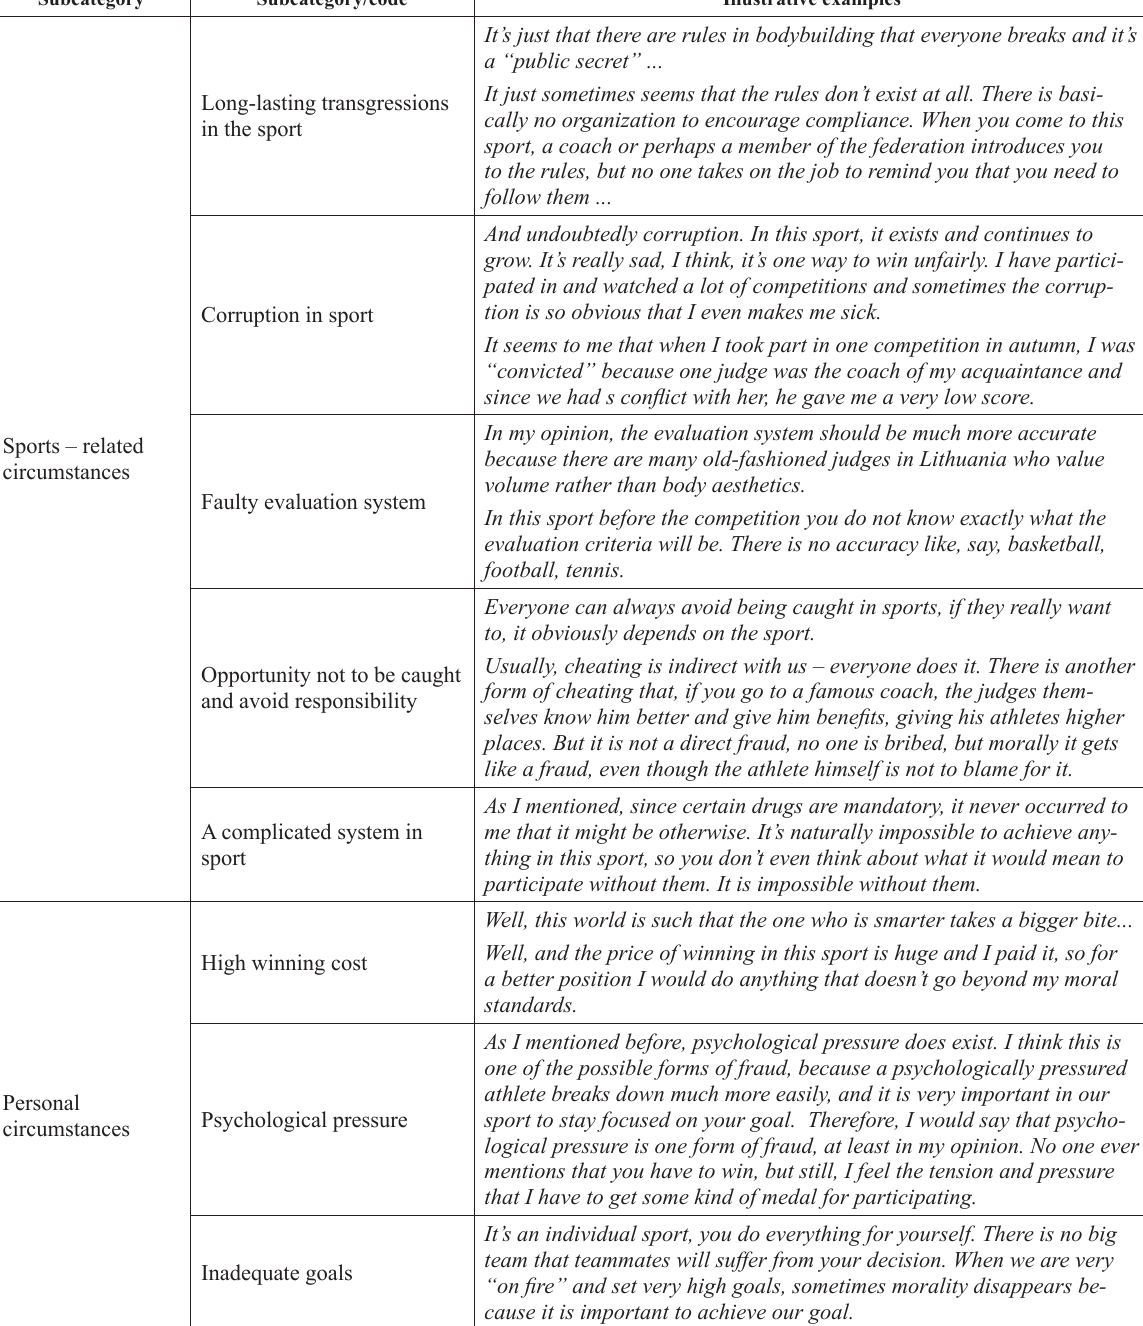
Table 5. Category: Negative circumstances